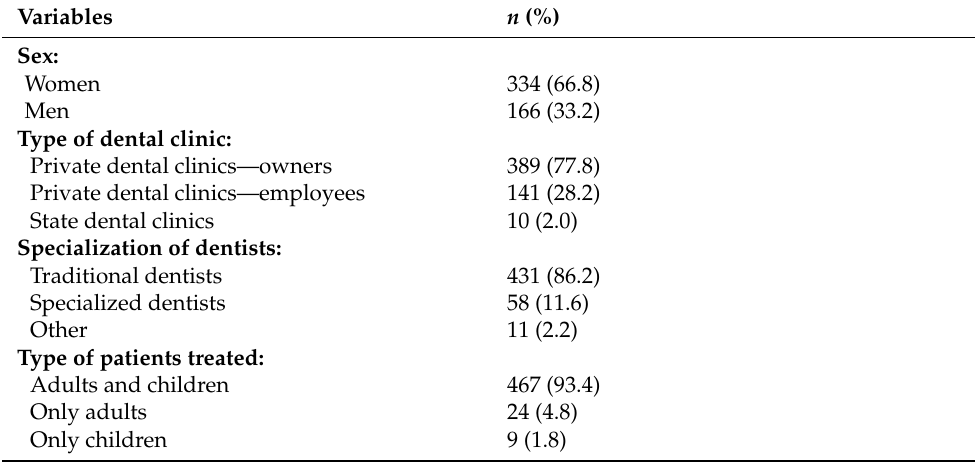
Table 1. Demographic characteristics of the respondents (Slovakia 2020; n = 500